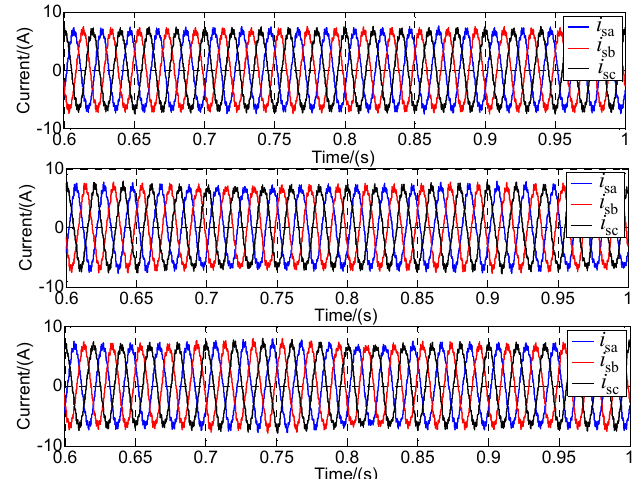
Figure 14. Stator currents of phases in the induction motor under the healthy, one broken bar and three broken bar conditions (top: health, middle: 1 broken bar, bottom: 3 broken bars).